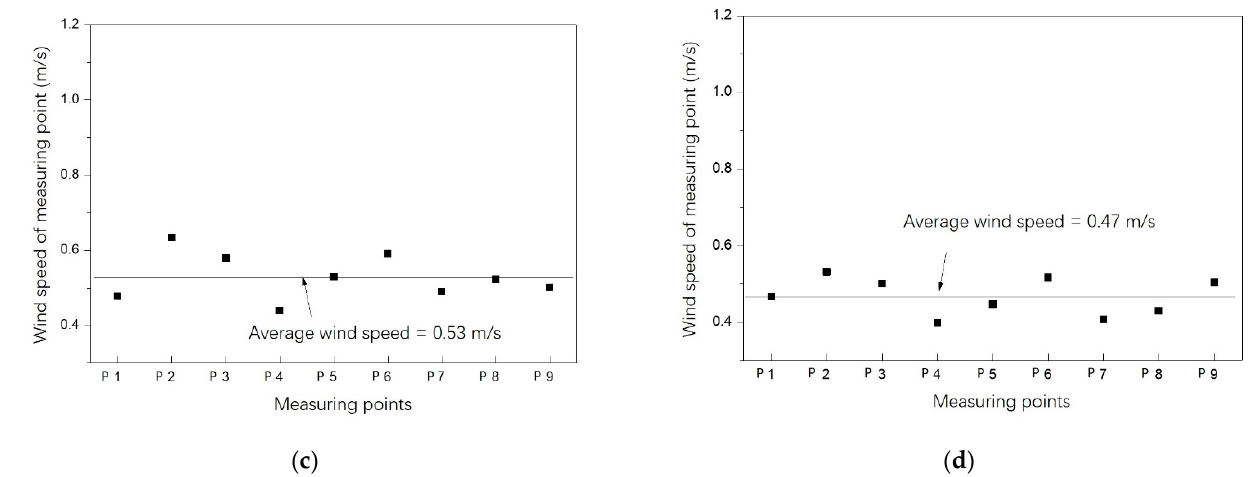
Figure 6. Wind speed of the measuring points on the different sections (case 2). ( a ) 2 m away from the air supply inlet; ( b ) 2.5 m away from the air supply inlet; ( c ) 3 m away from the air supply inlet; ( d ) 4 m away from the air supply inlet.